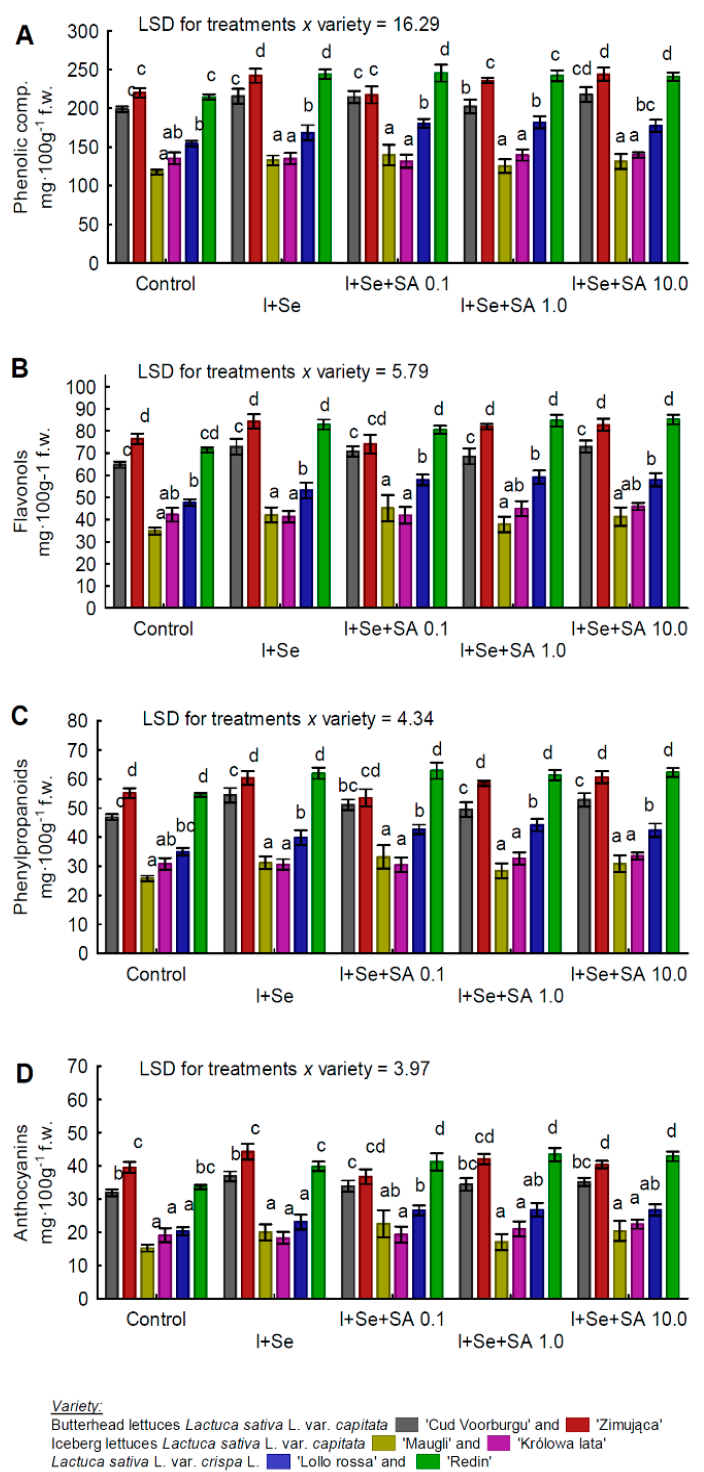
Figure 4. Concentrations of phenolic compounds ( A ), flavonols ( B ), phenylpropanoids ( C ), and anthocyanins ( D ) in lettuce. Means for cultivars followed by the same letters separately for each treatment (type of nutrient solution) are not significantly di ff erent at p < 0.05. LSD for interaction “treatments × variety” at p < 0.05. Bars indicate standard errors ( n = 8). f.w.—fresh matter weight.